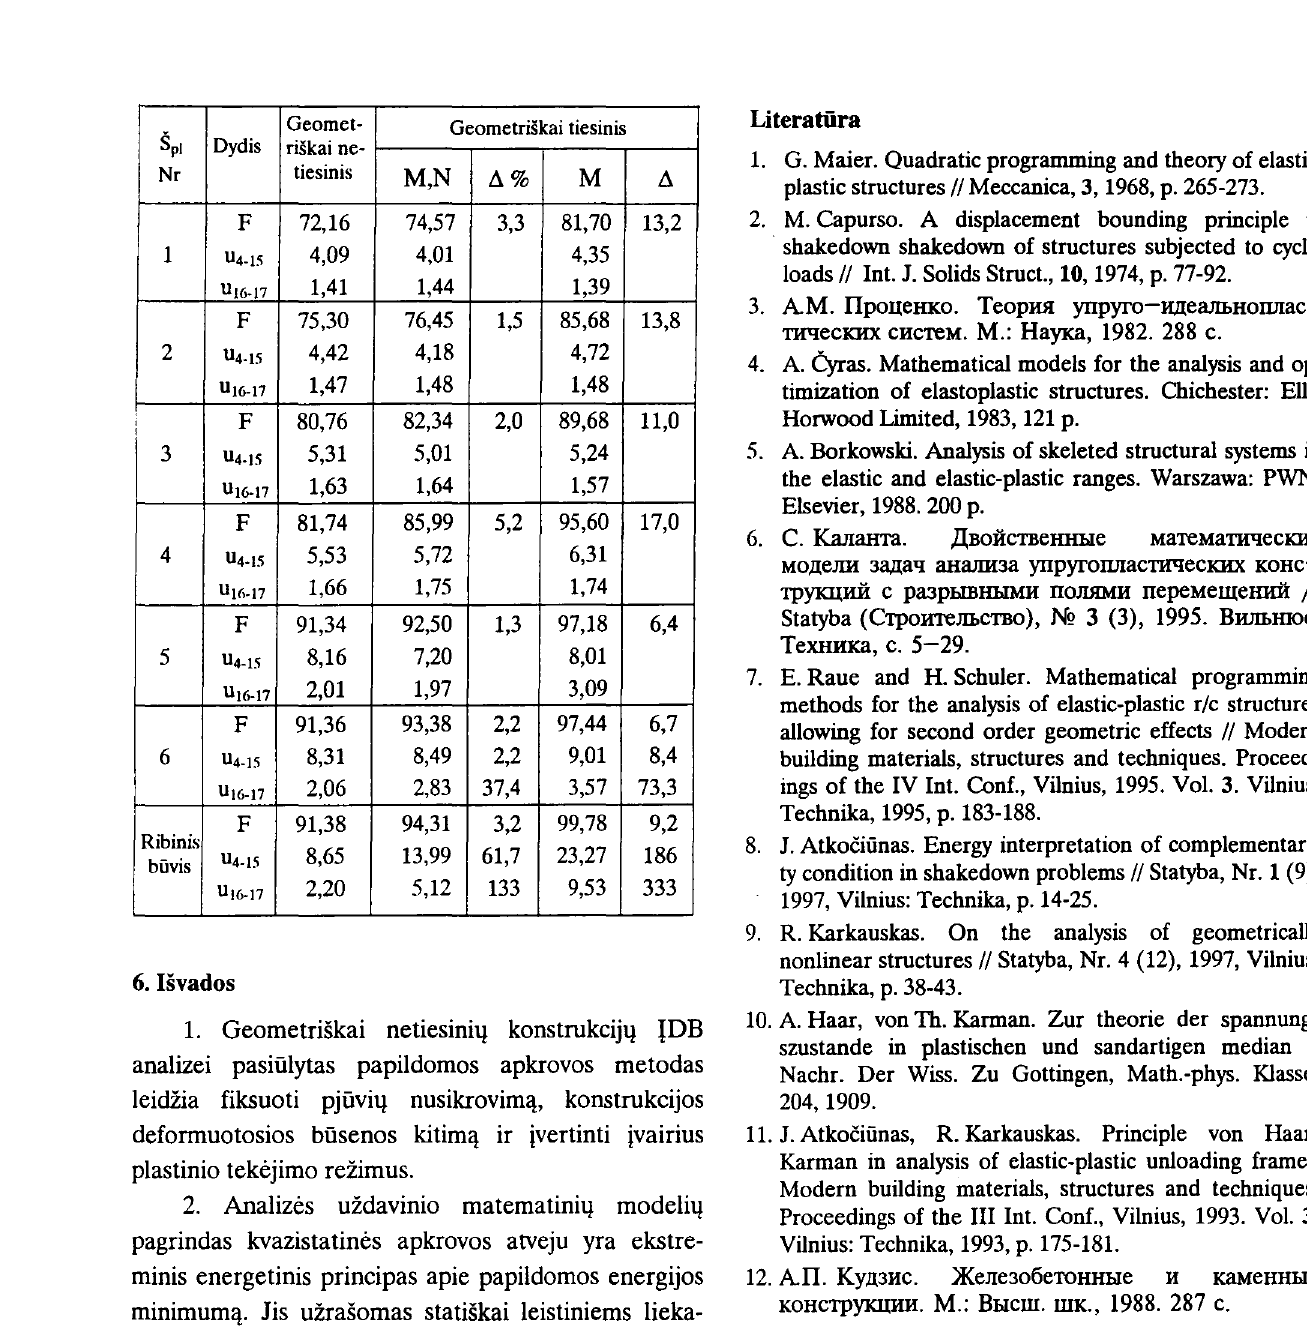
minimum~. Jis uzrasomas statiskai leistiniems